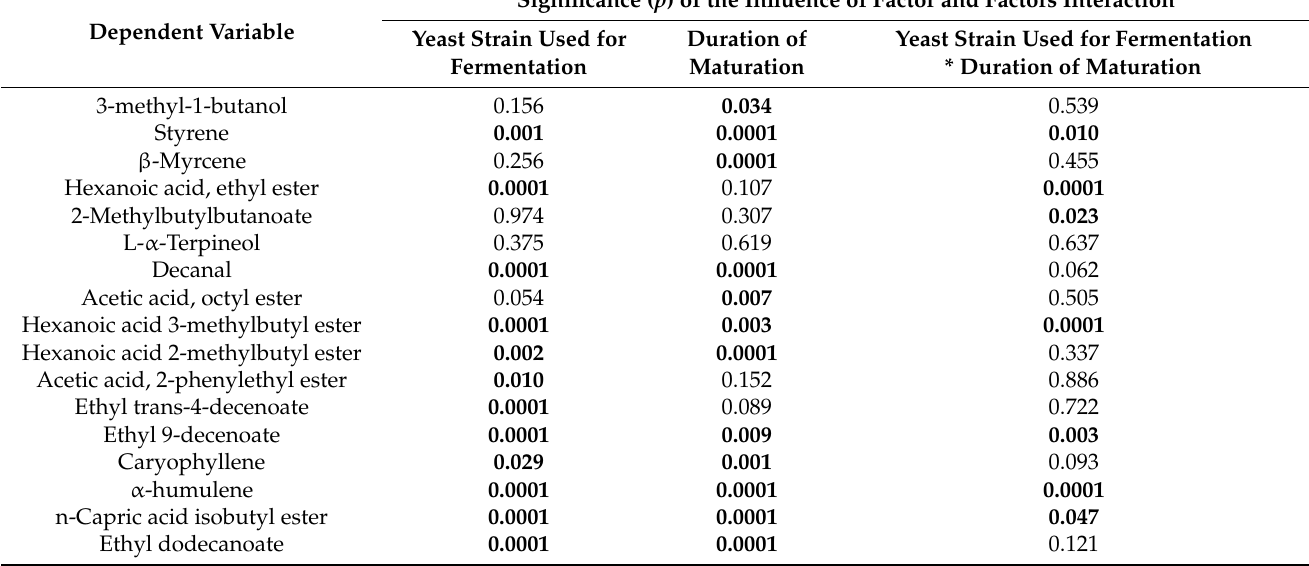
Table 5. Influence of the analysed factors on beer volatile compounds